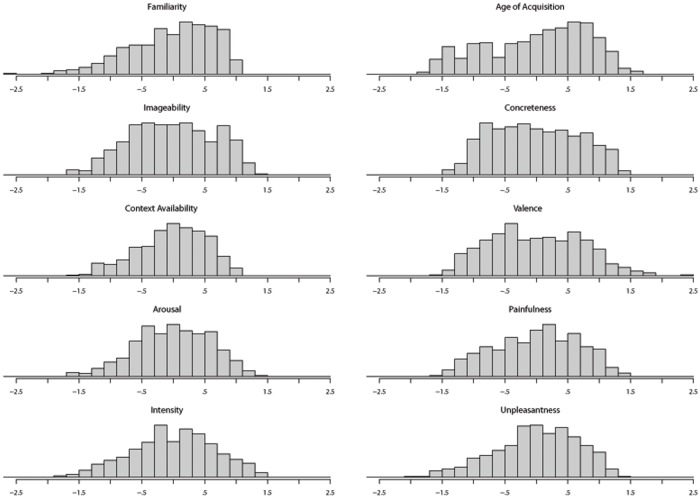
Variables distribution.Distribution of the variables in the final dataset.